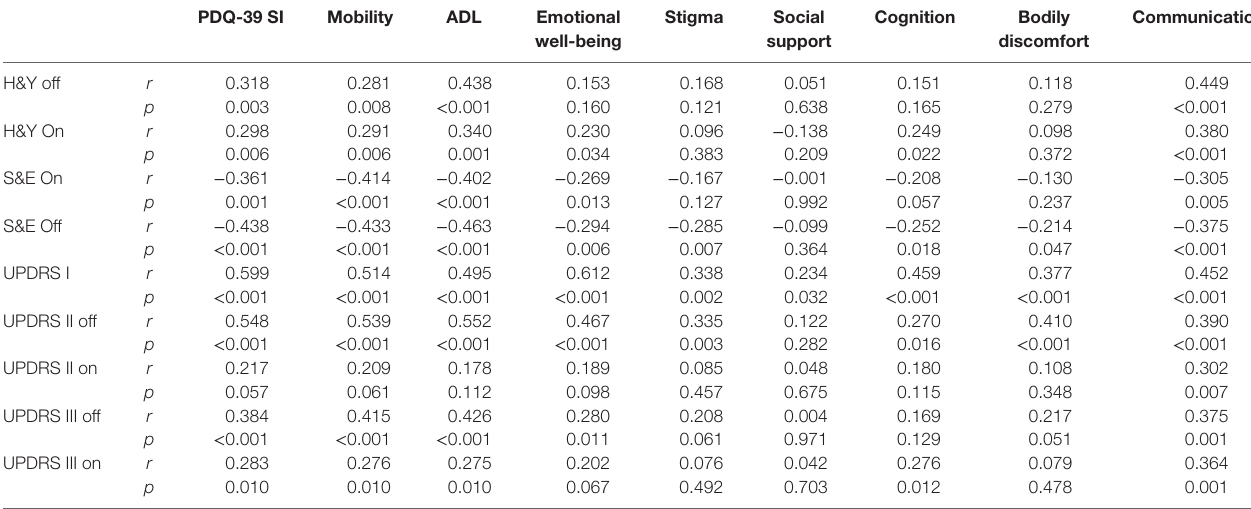
Table 3 | Correlations between quality of life domains and disease stage, patient disability and UPDRS subscores. PDQ-39 si Mobility aDl emotional